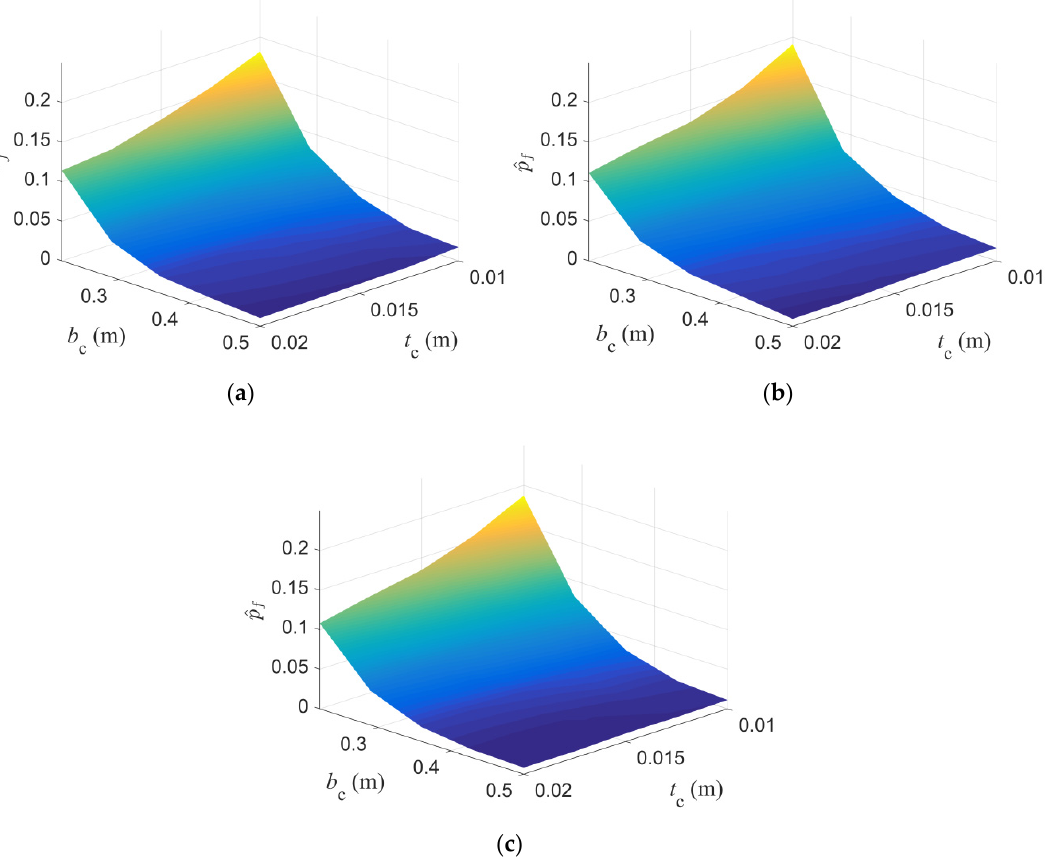
Figure 7. Surface of failure probability in Example 1. ( a ) MCS. ( b ) EGO-EGRA. ( c ) Proposed method.